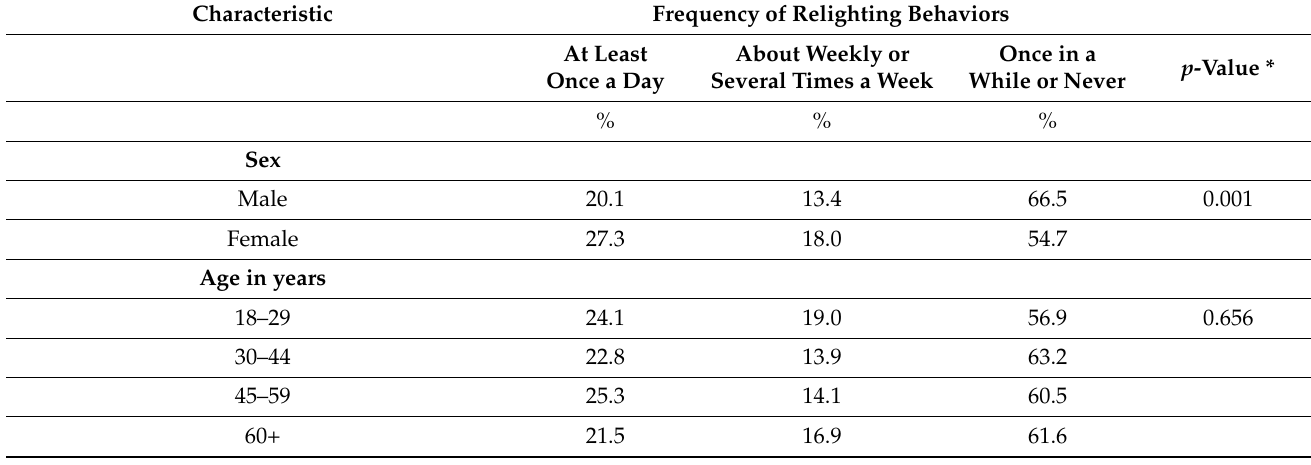
Table 2. Frequency of cigarette relighting behaviors by demographic characteristics and other smoking-related variables, 2021 survey data ( n =